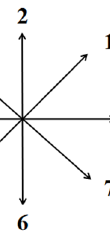
Figure 6. The eight-way code direction symbol.